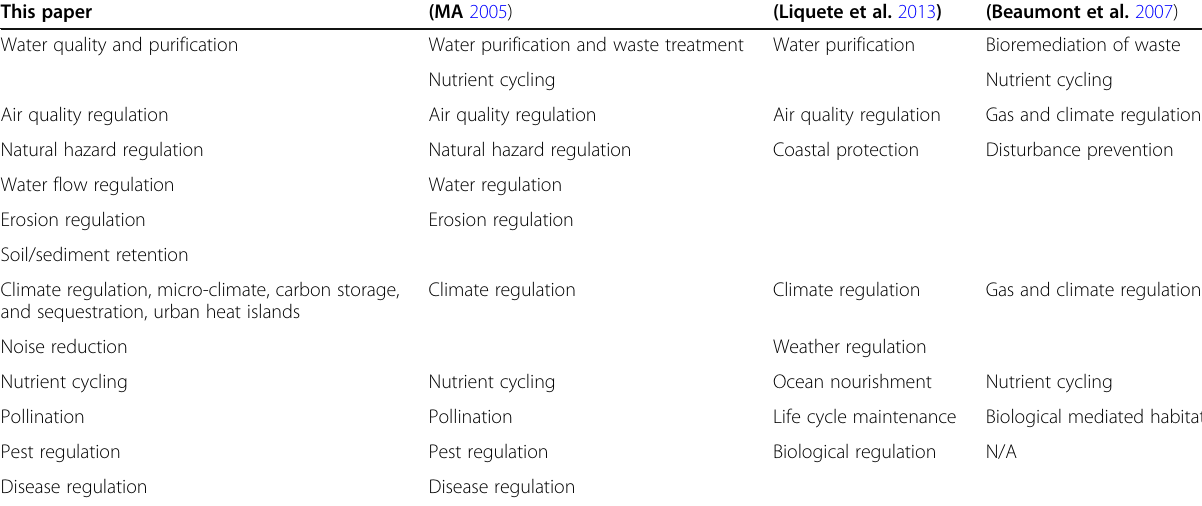
Table 2 The correspondence of the classification of RES proposed in this paper with other previous research work classifications This paper